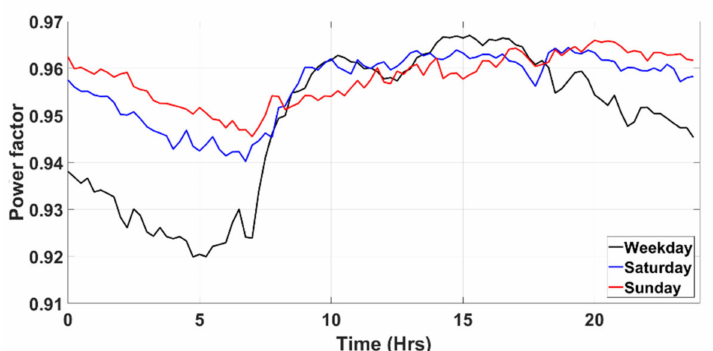
Figure 14. Power factor daily variation calculated at the PD01 feeder-substation coupling point for a weekday (black), Saturday (blue) and Sunday (red), load curve profiles for billed demands only.